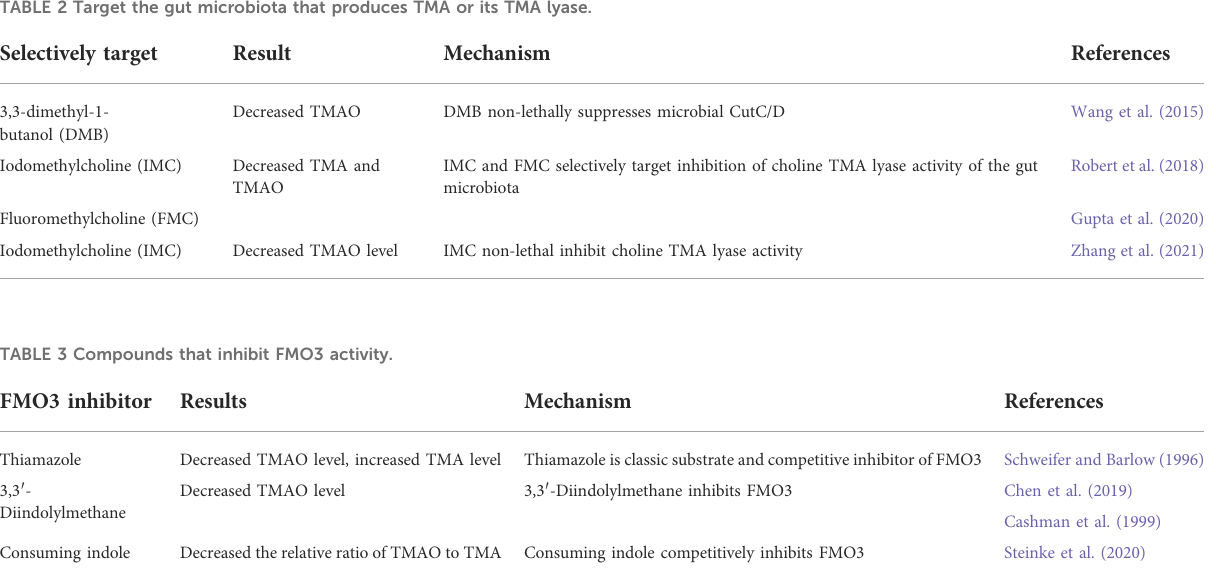
TABLE 2 Target the gut microbiota that produces TMA or its TMA lyase.